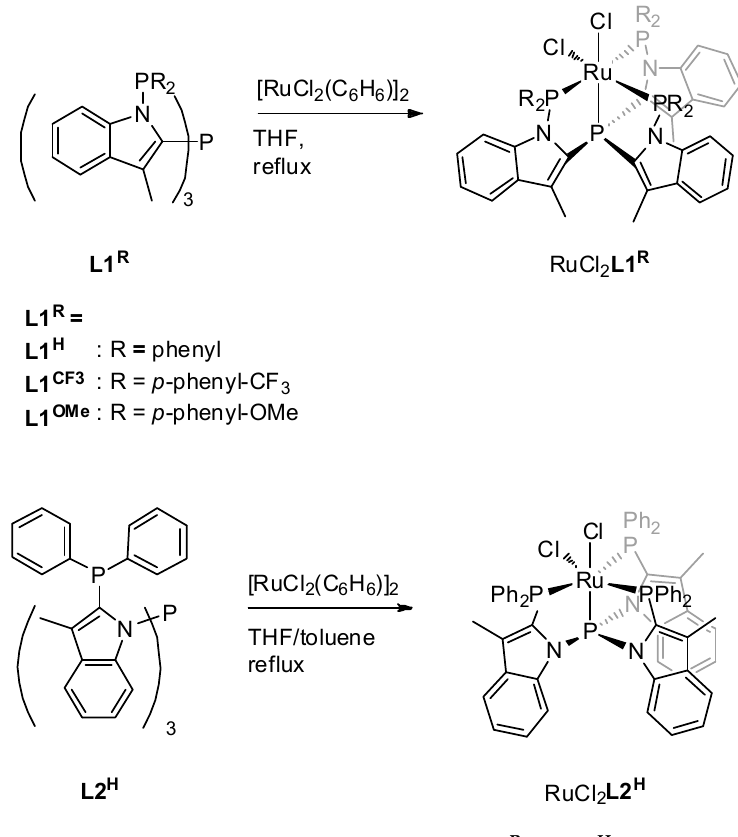
Figure 2. Ruthenium complexes of L1 R and L2 H .